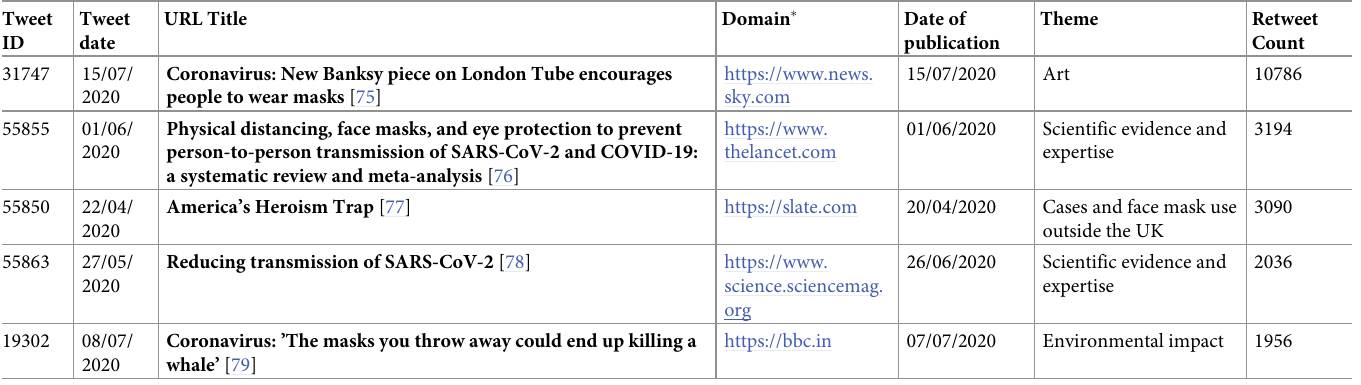
Table 5. URL titles of the top 5 ‘most retweeted tweets’ (subheadings excluded).